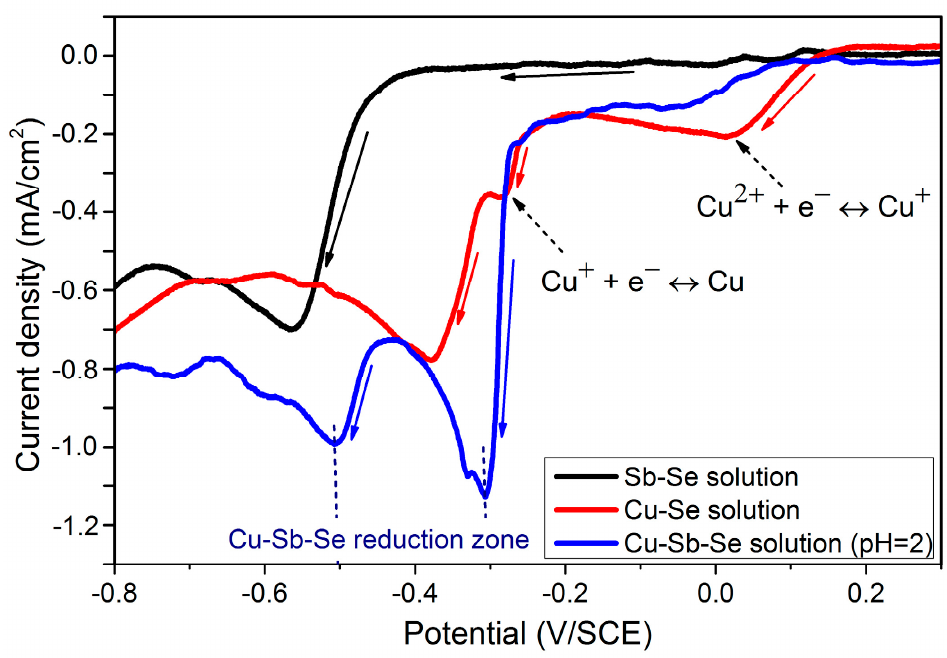
Figure 2. Voltammograms of FTO-coated electrode in Cu–Se, Sb–Se and Cu–Sb–Se solutions